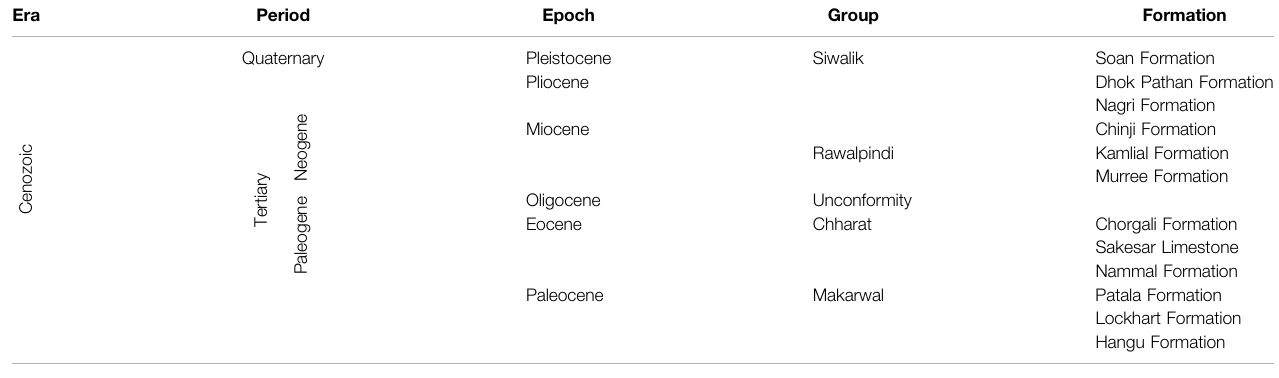
TABLE 1| Generalized stratigraphic column ofCenozoicEra forPotwar Basin. Atotal offour groups, includingMakarwal group ofPaleocene age,Chharat group ofEocene age, Rawalpindi group of Miocene age, and Siwalik group of Miocene-Pleistocene age. Murree Formation, included in the Rawalpindi group of Miocene age, is investigated for the determination of abnormal pressure zones (Shah, 2009).